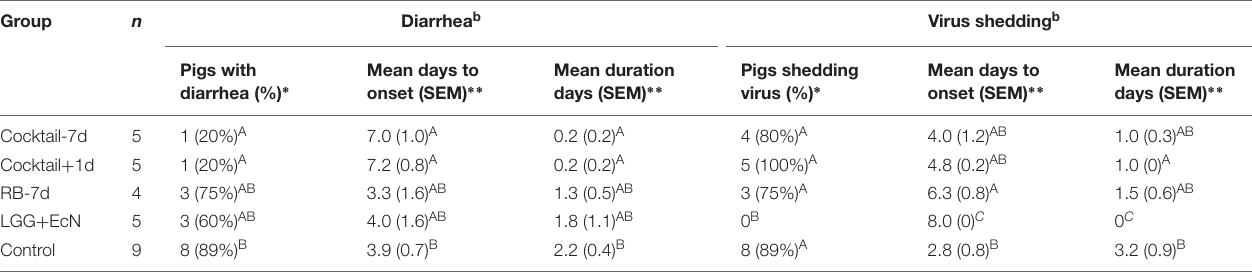
TABLE 1 | Incidence of diarrhea and fecal virus shedding in Gn pigs after HuNoV GII.4 challenge a .